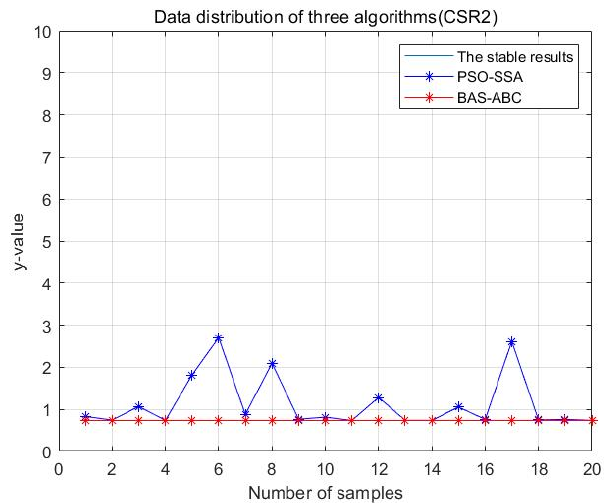
Figure 30. Data distribution—20 of two hybrid algorithms (CSR1).